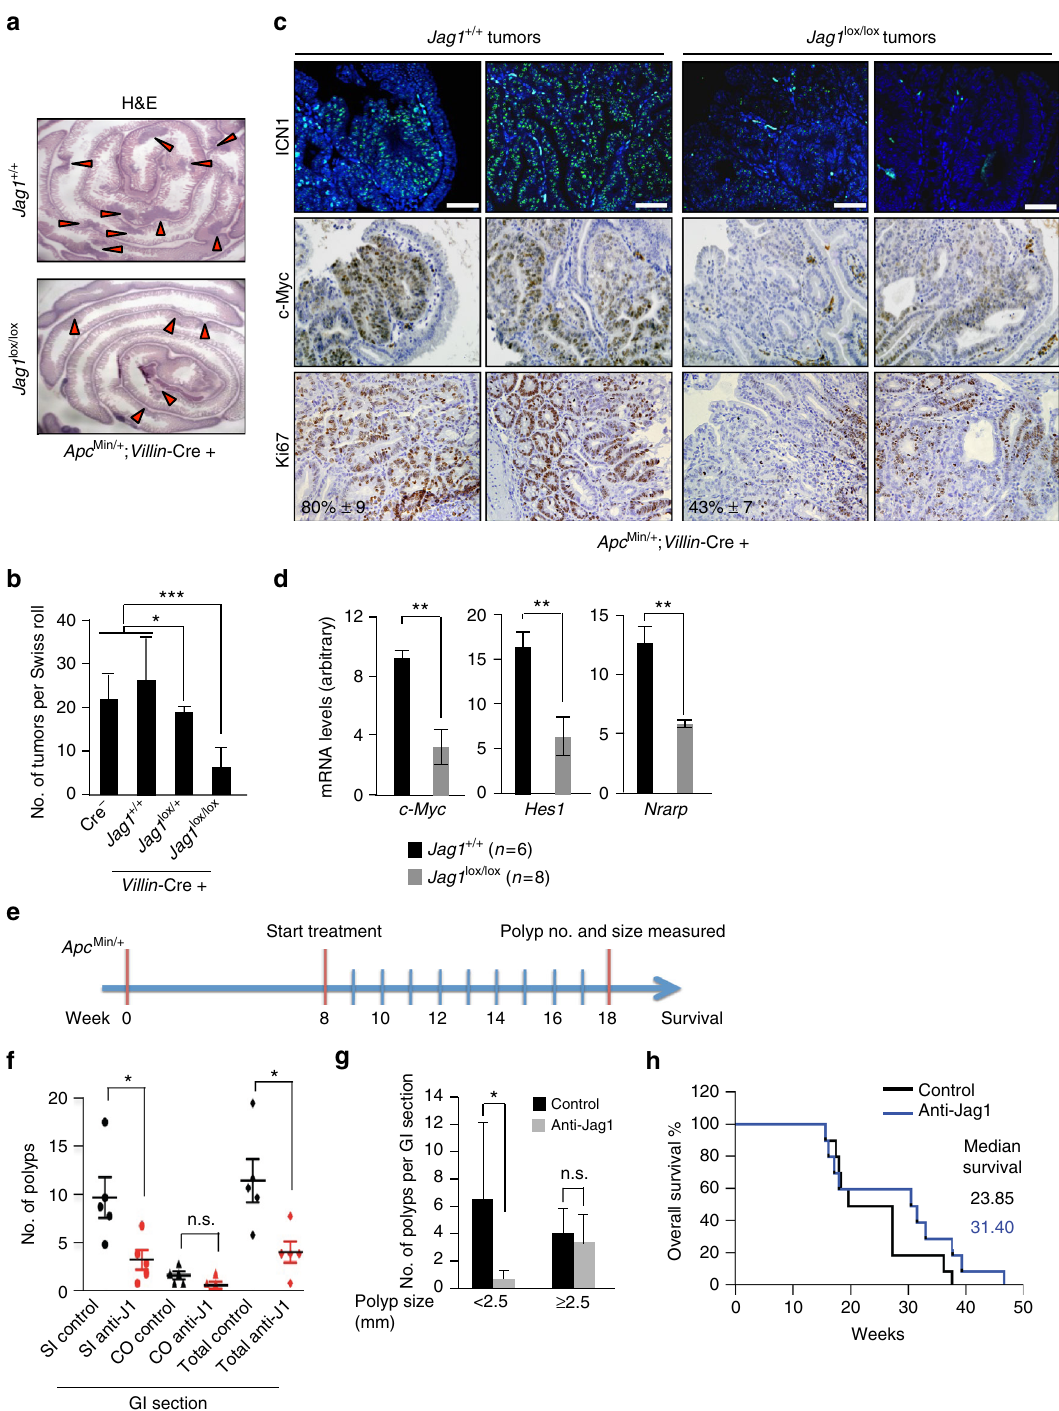
Fig. 1 Jag1 is required for tumor initiation and tumor-associated Notch signaling. a Intestine Swiss-roll images from representative Apc Min/ + ; Jag1 wild-type ( Jag1 + / + ) or knockout ( Jag1 lox/lox ) mice obtained with the stereomicroscope. Red arrowheads denote intestinal tumors. b Quanti fi cation of tumor number per Swiss-roll section in the indicated genotypes analyzed at 2.5 – 3 months of age. c IF or IHC analysis of two representative Apc Min/ + ; Jag1 + / + or Jag1 lox/lox adenomas showing the levels of active Notch1 (ICN1) and c-Myc, and the proportion of proliferating cells determined by Ki67 staining. d qRT-PCR analysis to determine the mRNA levels of the indicated Notch targets in tumors from different genotypes relative to β 2-microglobulin . e Apc Min/ + ; Villin -Cre mice were dosed weekly for 10 weeks with 10mg per kg of either isotype control (black in f ) or anti-Jag1 blocking antibodies (red in f ) starting at 8 weeks of age ( n = 5 per treatment group), near the onset of polyp formation. f , g Number of polyps that grew in total ( p = 0.0175), in the small intestine (SI) ( p = 0.025), where most polyps arise in this model, or in the colon (CO) ( f ) and analysis of polyp size in the same experiment ( g ). h Overall survival analysis in separate cohorts of 10 animals per treatment group that received weekly doses beginning at 8 weeks of age. Bars represent mean values ± standard error of the mean (s.e.m.); p values were derived from an unpaired t -test, two-tailed (* p <0.05, ** p < 0.01, and *** p < 0.001). Scale bars represent 75 μ